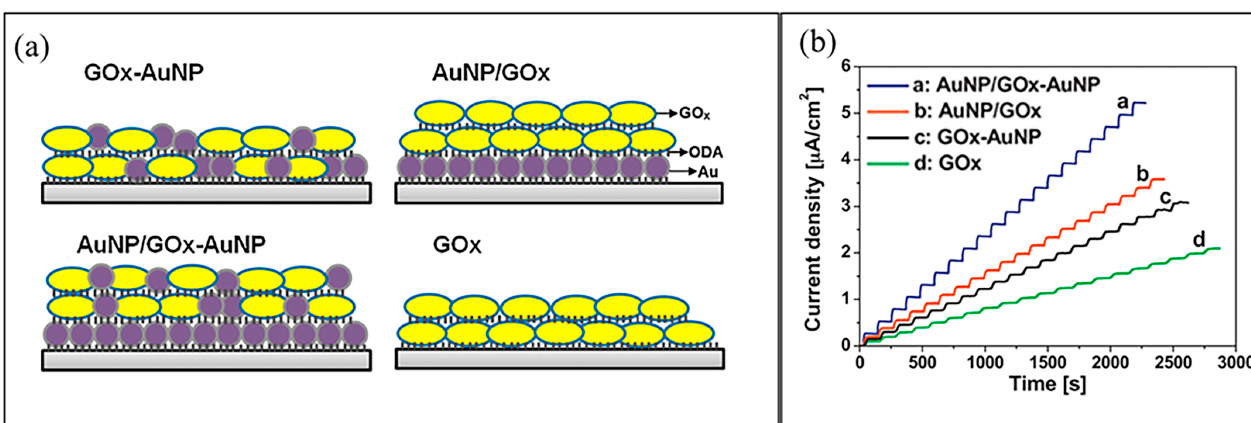
Figure 7. Four structural designs of GOx and AuNP composite film-modified ODA-Pt electrodes: ( a ) schematic and ( b ) amperometric response. Reprinted with permission from ref. [127]; Copyright 2016 Elsevier.